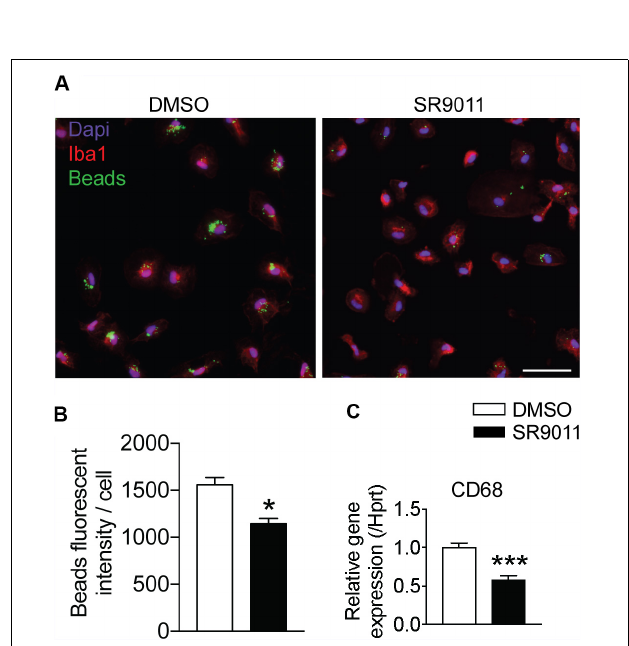
FIGURE 5 | SR9011 decreased phagocytic activity in primary microglia. (A) The uptake of fluorescent beads by primary microglia treated with DMSO or SR9011. (B) Primary microglia treated with SR9011 exhibit decreased phagocytic activity ( n = 15). (C) The expression of phagocytic marker CD68 is decreased in primary microglia treated with SR9011 for 12 h ( n = 6). Data are presented as means ± SEM and statistical significance was determined using Unpaired t -test in all experiments. p < 0.05* and p < 0.001*** vs.